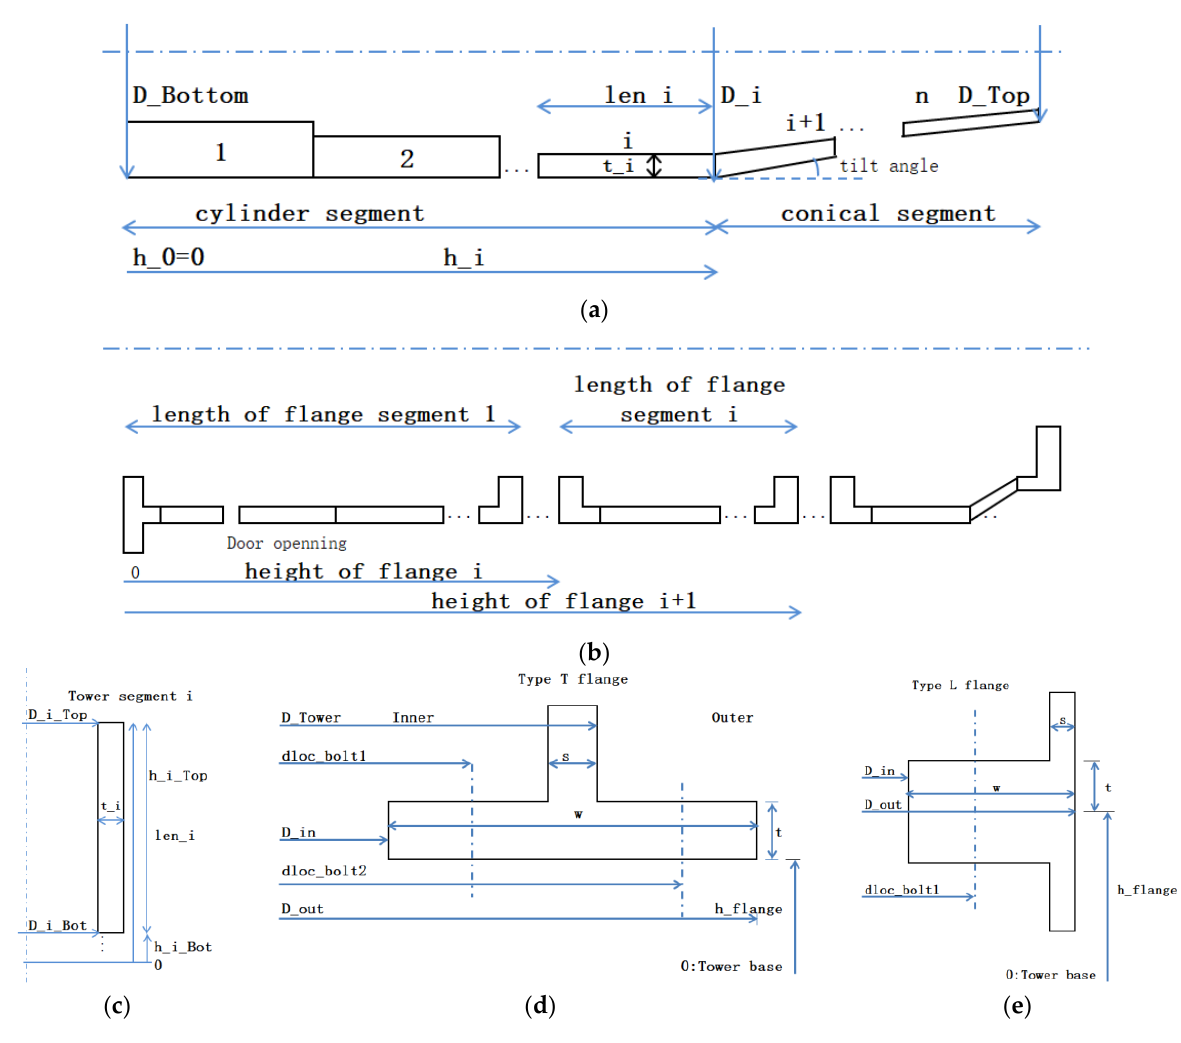
Figure 1. Geometry dimensions of tower and bolted connection ( a ) Tower segment profile (without flange); ( b ) Tower flange segment profile; ( c ) Tower segment; ( d ) Bottom flange (T Type); ( e ) Flange (L Type).